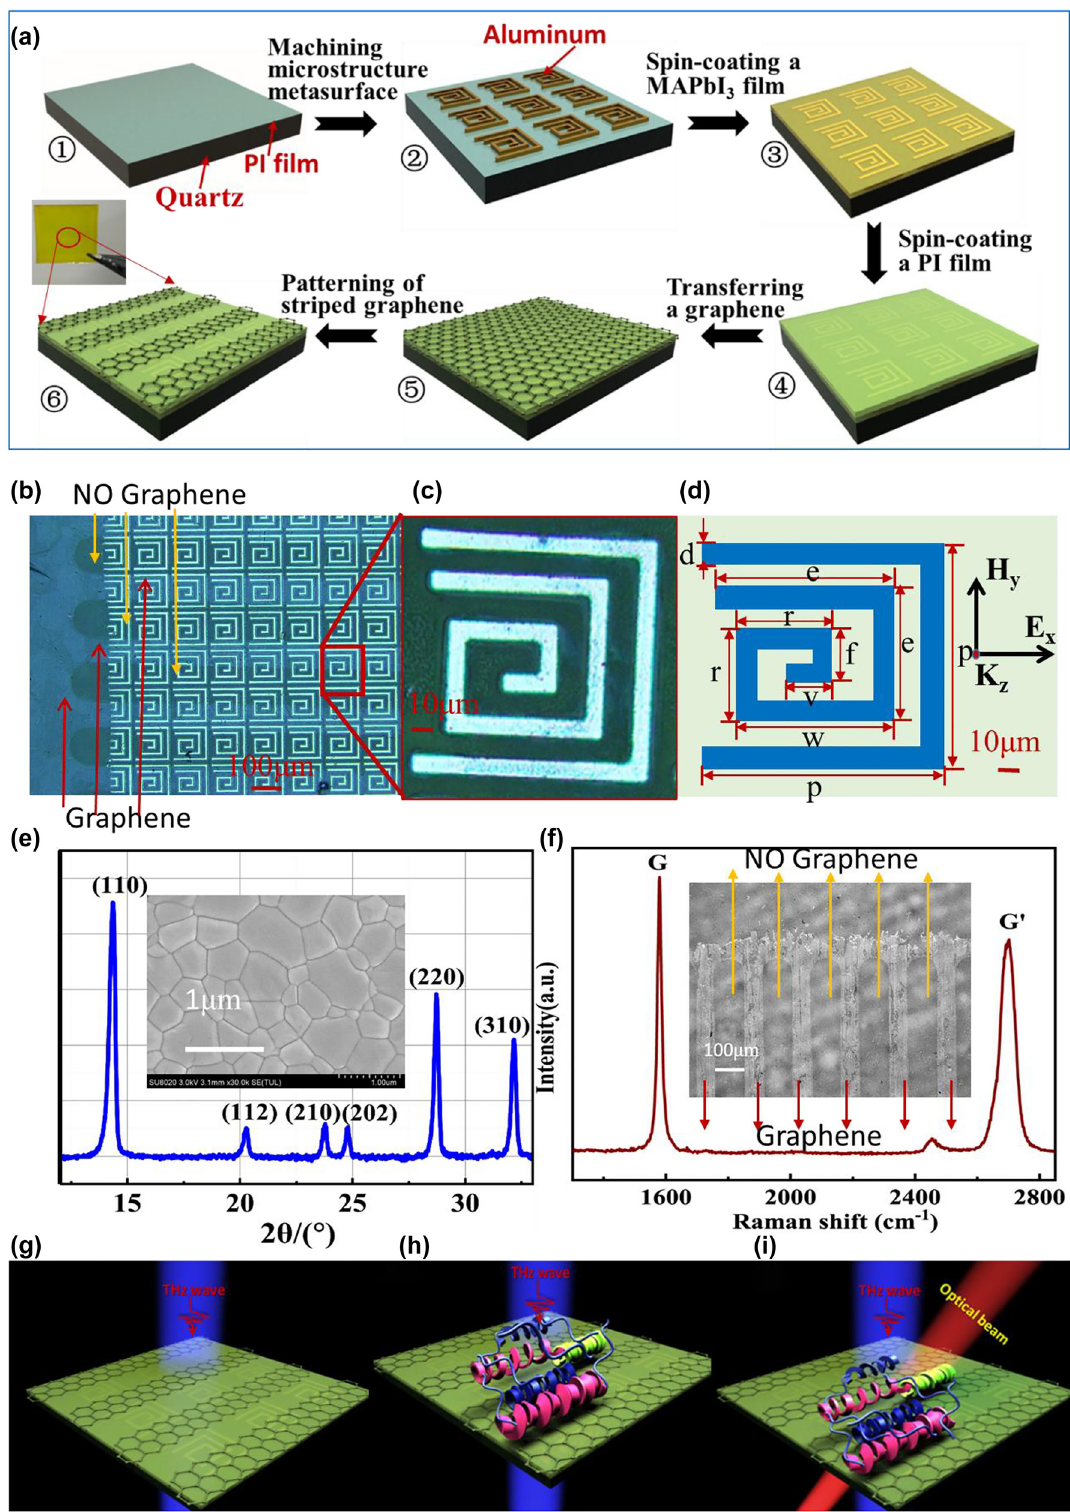
Figure 1: Fabrication and characterization of the proposed PGPP@MS biosensor. (a)Thefabricationprocess. ① API fi lmwasspin-coatedontopofaquartzsubstrate. ② Themetasurface,anasymmetricAlmicrostructure,was machinedatopthePI fi lm. ③ Ametalhalideperovskite(MAPbI 3 ) fi lmwasspin-coatedonthemetasurface,coveringthemicrostructure. ④ The PI fi lmwasspin-coatedontotheMAPbI 3 fi lm. ⑤ AgraphenelayerwastransferredontothePI fi lm. ⑥